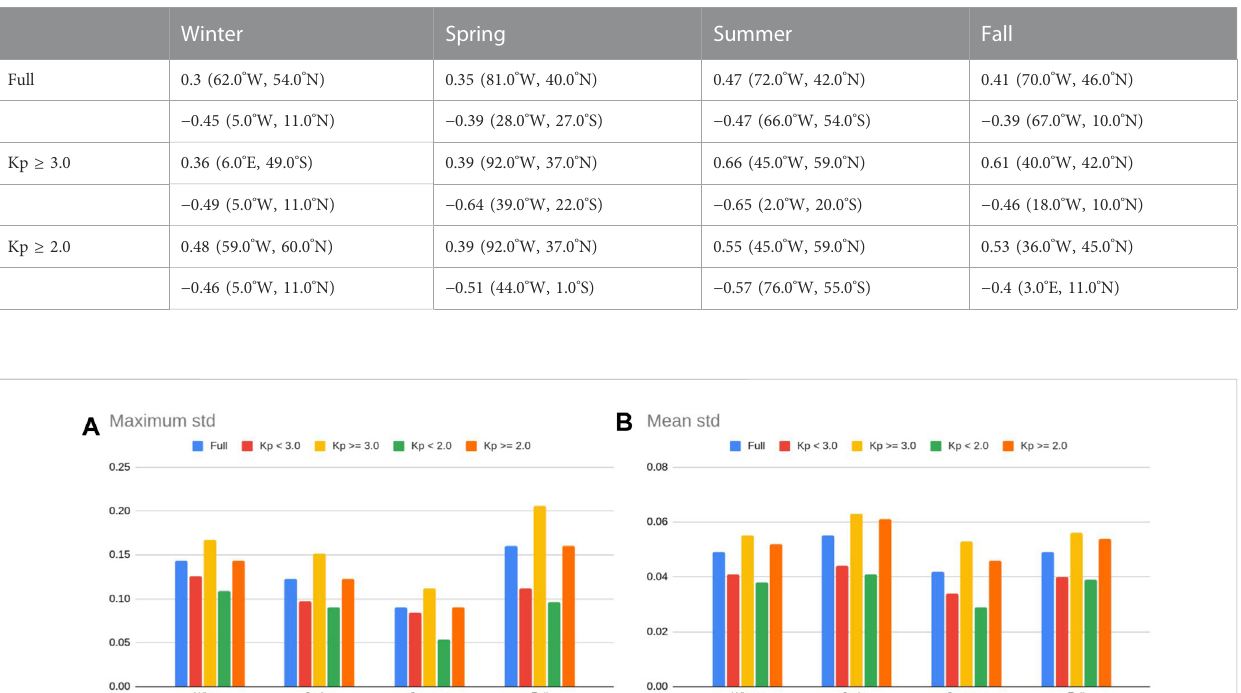
(Figure 6D). Similar trends exist for Kp ≥ 3.0 and Kp ≥ 2.0 of the positive correlation regions, and for maximum correlation values (Figure 6E). For example, when all data points are considered, the maximum positive correlations are 0.30, 0.35, 0.41, and 0.47 for Winter, Spring, Fall, and Summer respectively. The absolute values